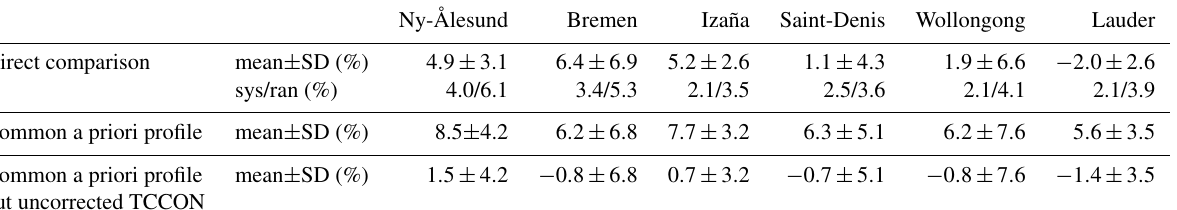
Table 4. The relative mean and SD between the TCCON and NDACC X CO measurements ((NDACC-TCCON)/NDACC × 100%) at six sites, together with the systematic and random uncertainties of the differences between public TCCON and NDACC measurements. The relative mean and SD between the TCCON and NDACC (with and without correction) X CO measurements using the common optimal a priori profile.